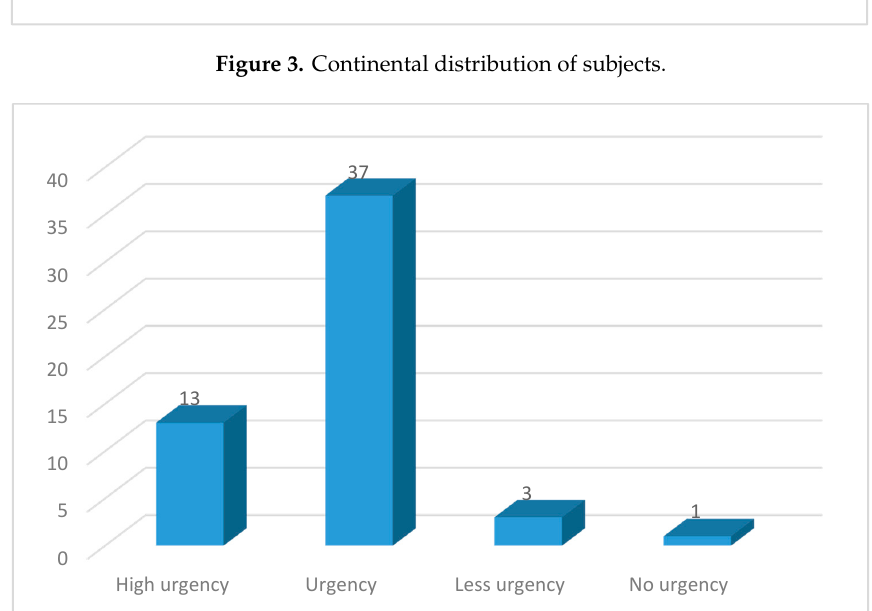
Figure 4. Swiss Emergency Triage Scale depicting the number of cases per category. Table 5. Types of admission and discharge for LMIC subjects.